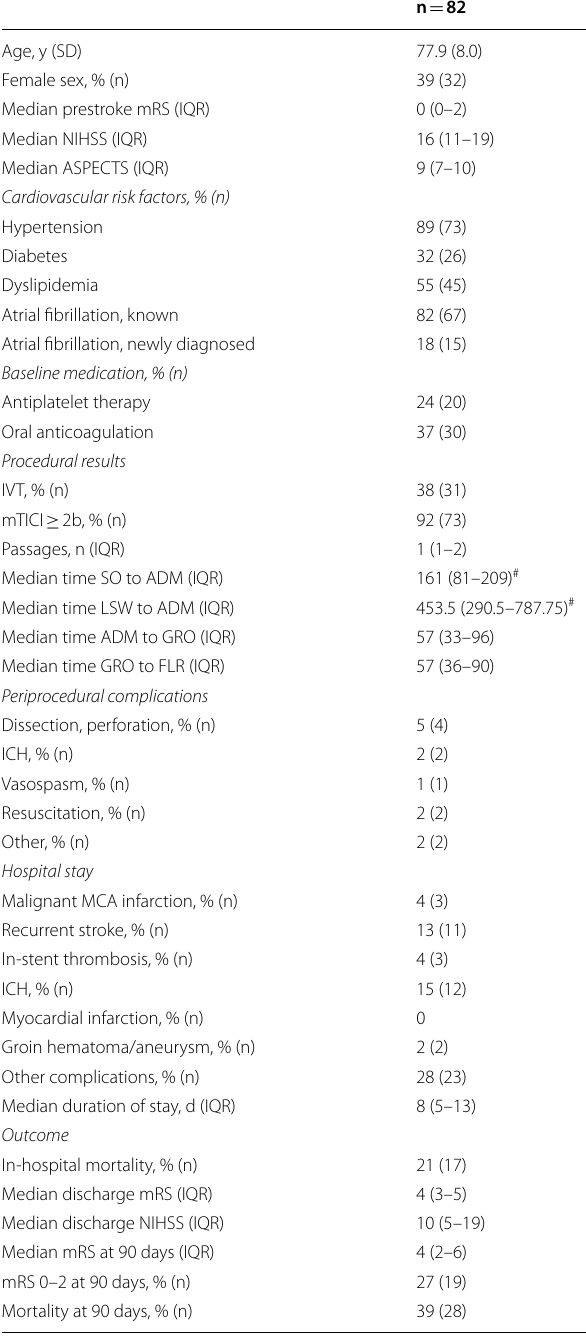
Table 1 Description of baseline, periprocedural and outcome